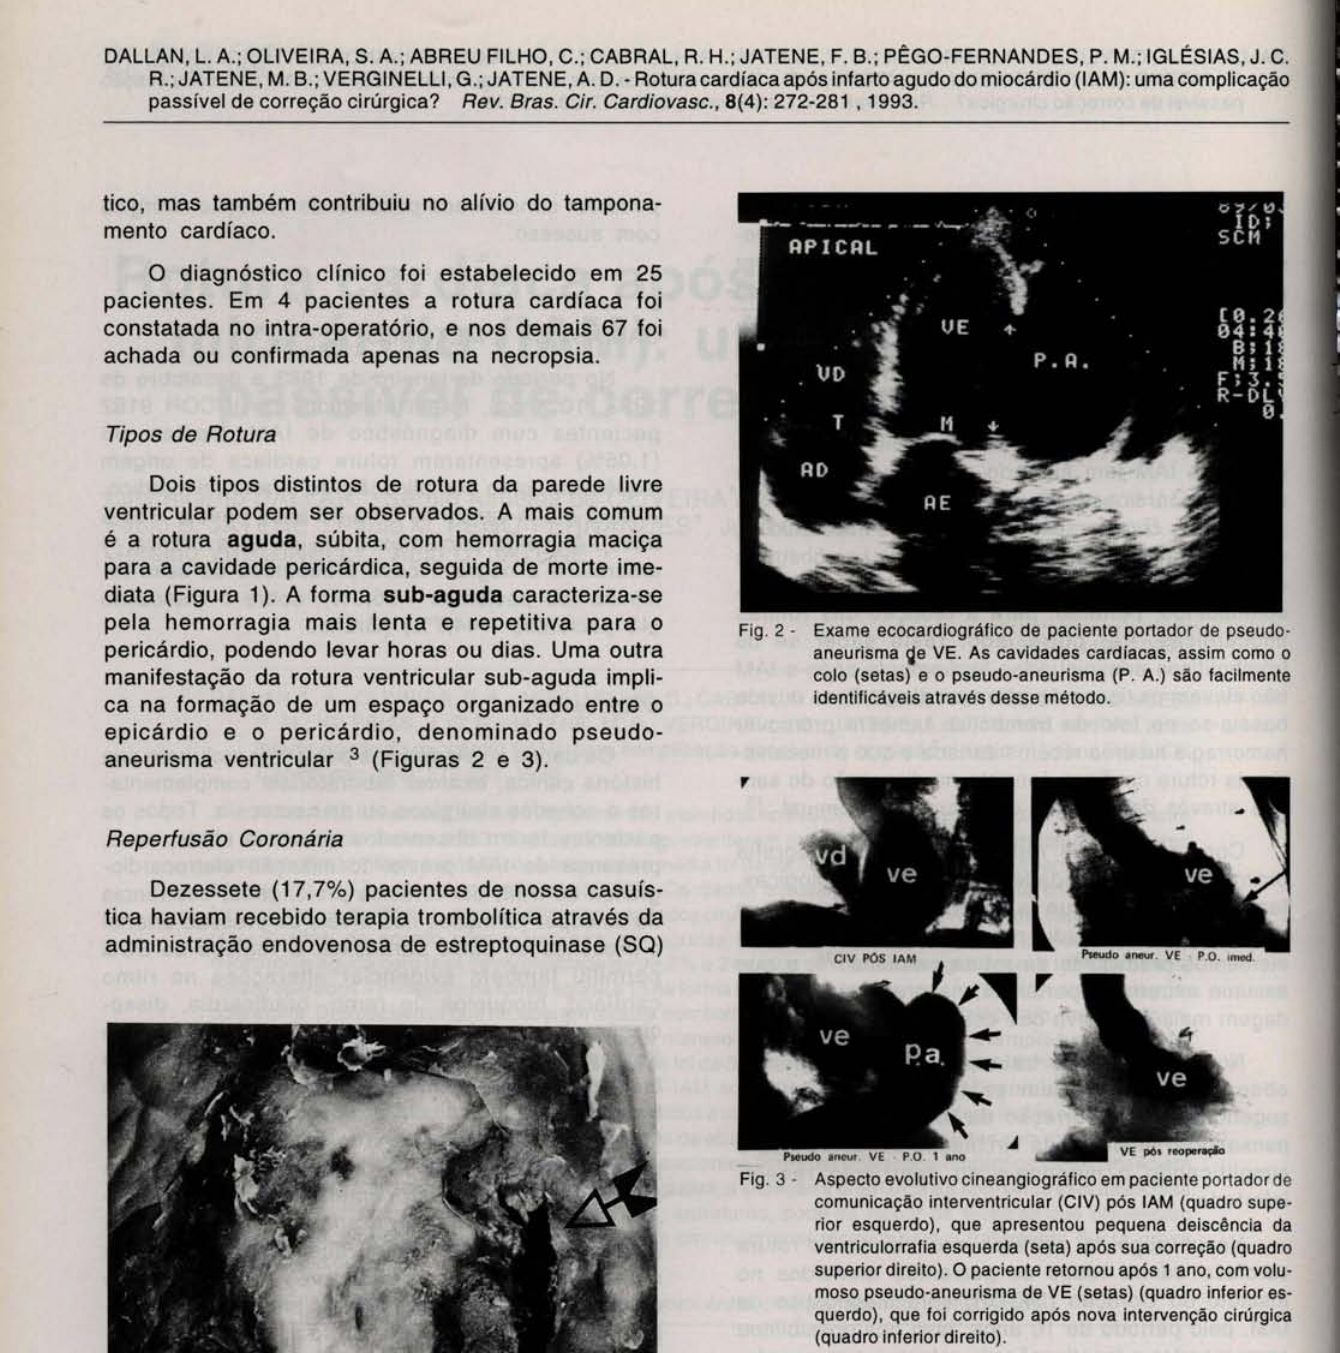
Fig. 3· Aspecto evolutivo cineangiográfico em paciente portador de comunicação interventricular (CIV) pós IAM (quadro